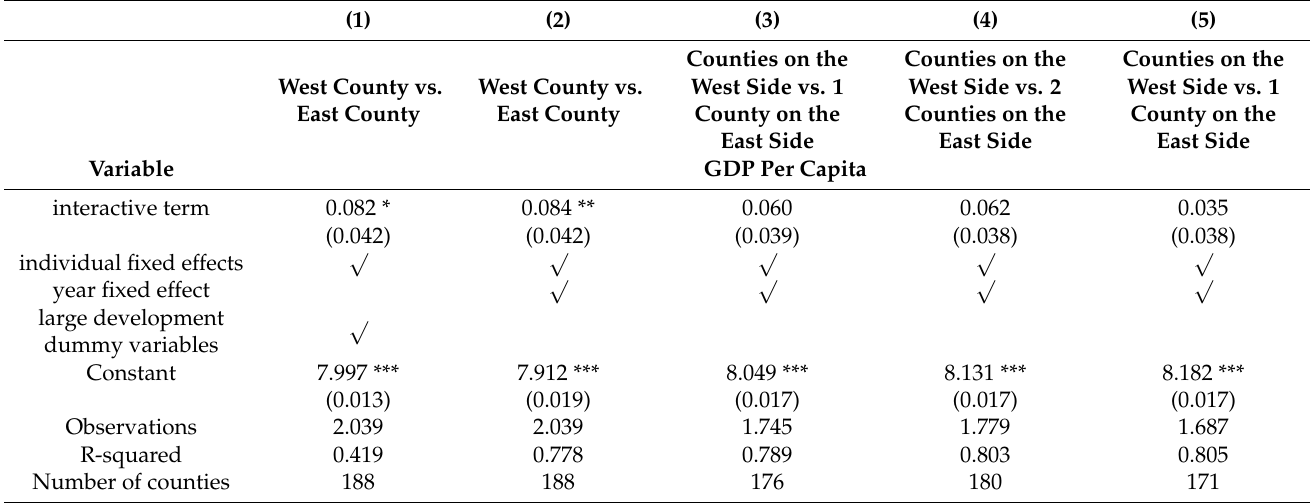
Table 9. Western Development and GDP per capita (tested by different groups)